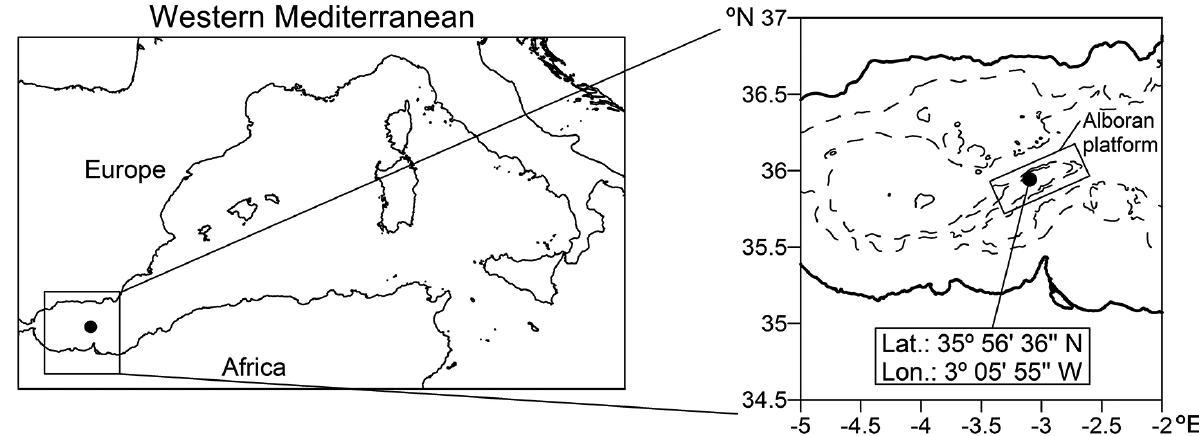
Fig. 1. – Map of the area indicating (with a black dot) the locality of the beam trawls in which the Protogrammus alboranensis n. sp. was caught. Isobaths correspond to 600 and 1000 m depth. Alboran Island, more or less in the centre of the Alboran platform, is so small that it barely appears at the scale of the